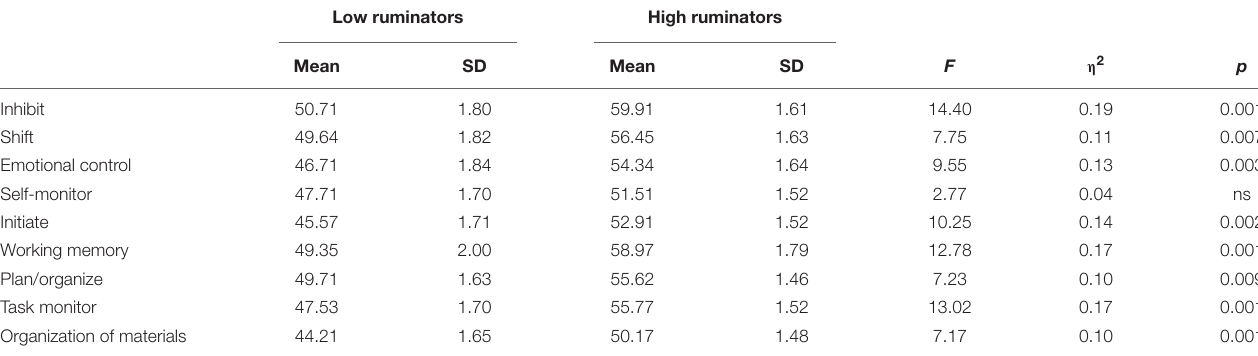
TABLE 2 | T-Score means, standard deviations and ANOVA results for the subscale measures of the BRIEF-A, separated by rumination